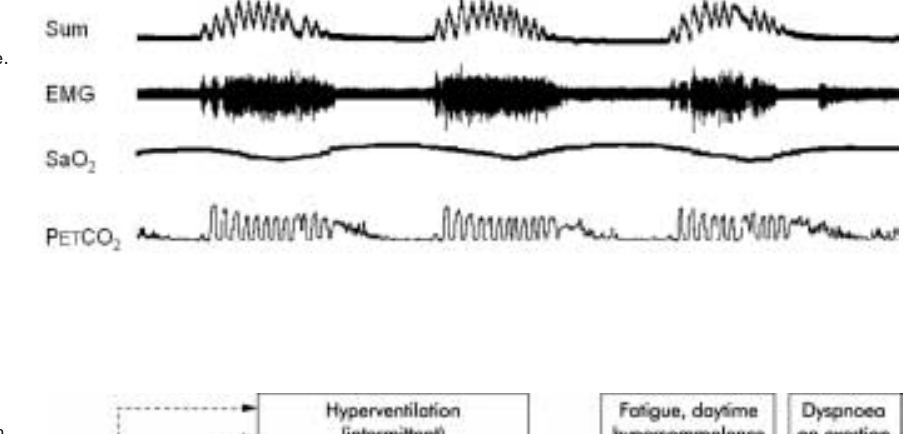
Patho-physiology of Cheyne-Stokes respiration in patients with congestive heart failure (CHF). CHF causes pulmonary congestion and there- fore activates pulmonary J receptors which stimulate ventilation. PaCO 2 falls below the apnoea threshold and, during the subsequent apnoea, paCO 2 raises and paO 2 falls until the apnoea threshold is exceeded. The restart of ventilation coincides with an arousal which also stimulates sympathetic nerve activity (SNA) and catecholamine release. The inter- mittently released catecholamines and the peri- odic increases of SNA cause oscillatory surges of heart rate and blood pressure which addi- tionally strain the failing heart and therefore may worsen CHF (Figure from Thorax 2002;57:547–554 [21] with permission from the BMJ Publishing